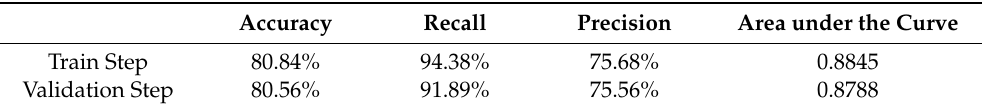
Table 5. Performance metrics of the clinical